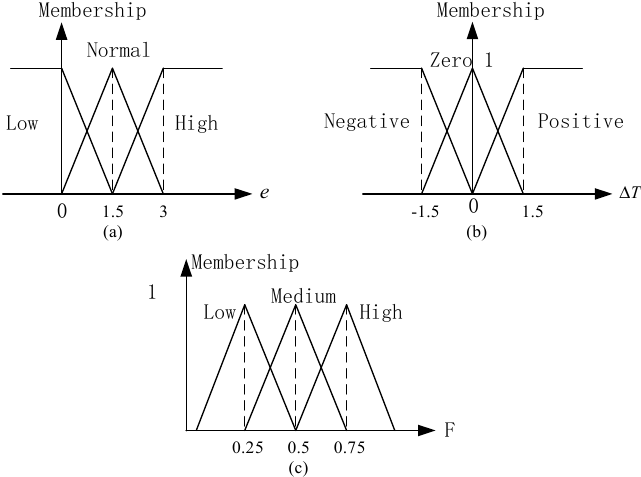
Figure 5. Membership function of the linguistic variables. ( a ) e, ( b ) Δ T , and ( c ) F.